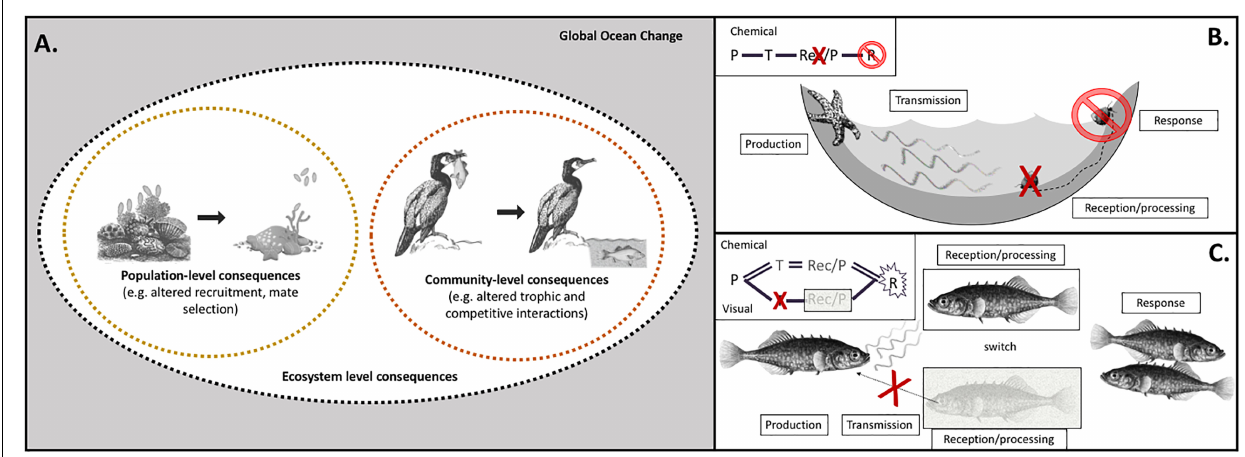
FIGURE 1 | Climate change factors affect individual steps of sensory pathways, with cascading impacts on ecological processes at scales of populations, communities, and ecosystems. (A) The sensitivity of individual pathway steps, as well as how effects on multiple steps combine to shape behavioral outcomes, mediates impacts of climate change on sensory ecology, with both population- and community-level consequences. Global climate change is composed of a suite of environmental factors in marine habitats that are shifting (gray box): temperature, carbonate chemistry, oxygen, salinity, ultraviolet radiation, turbidity, hydrodynamics, stratification, and nutrients. Ecological impacts of global change, both at the population and community levels, are mediated by sensory pathways of specific modalities (e.g., olfaction, vision). For example, disruption of production of olfactory cues may cause recruitment dynamics of coral larvae to change, resulting in population-level consequences. Disruption of visual cues alters predation success of cormorants, with consequences for dynamics of ecological communities. (B) Climate change factors impact sensory pathways at individual step(s) – production (P), transmission (T), reception/processing (Rec/P), which leads to an impaired response (R). For turban snails, ocean acidification disrupts the reception/processing of chemical cues produced by sea star predators. Instead of crawling out of the tidepool to escape predation, the snails cannot respond appropriately to the cue and experience higher mortality rates (Jellison et al., 2016). (C) Species that can compensate by switching to a different modality may be more resilient under climate change. When the transmission of visual cues is impaired, stickleback can switch to rely on olfactory cues for mate selection (Heuschele et al., 2009). Our framework addresses the existing need for a mechanistic articulation of the interaction between the environment, the cue/signal producer, and the recipient organism to better predict ecological consequences of climate